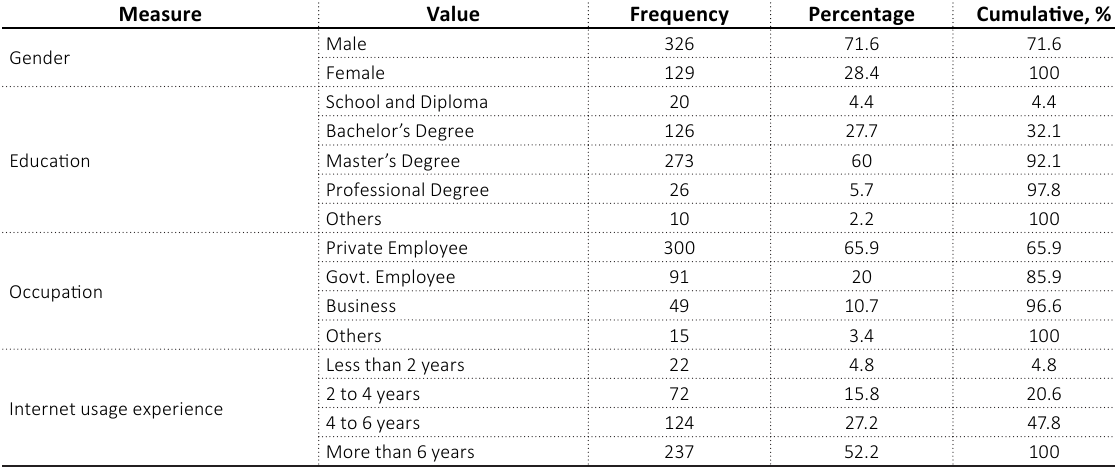
Table 1. Profile of